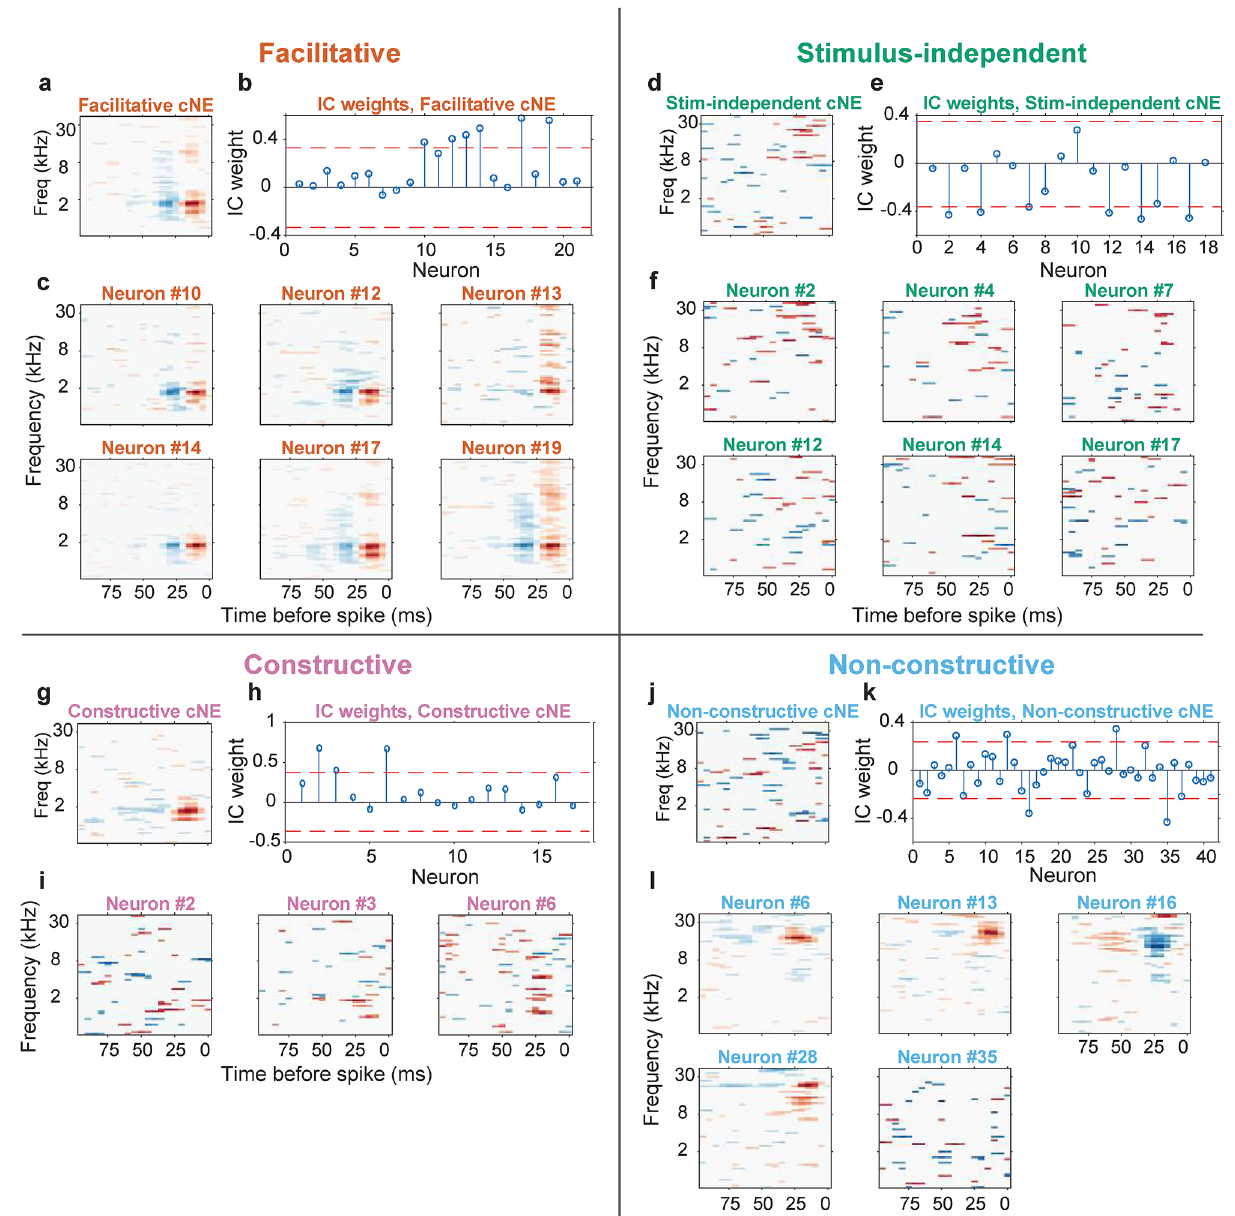
Figure 2. STRFs of cNEs and member neurons. ( a – c ) Facilitative cNE is STRF + and most of its member neurons are also STRF +. ( d – f ) Stimulus-independent cNE is STRF− and most of its member neurons are also STRF− . ( g – i ) Constructive cNE is STRF + but most of its member neurons are STRF− . ( j – l ) Non-constructive cNE is STRF− but most of its member neurons are STRF +. ( a , d , g , j ) STRFs of the cNEs. ( b , e , h , k ) IC weights for each cNE. The magnitude of the IC weights represents the contribution of each neuron to the cNE. Red dashed lines: thresholds that determine if a neuron is a member of the cNE. ( c , f , i , l ) STRFs of member